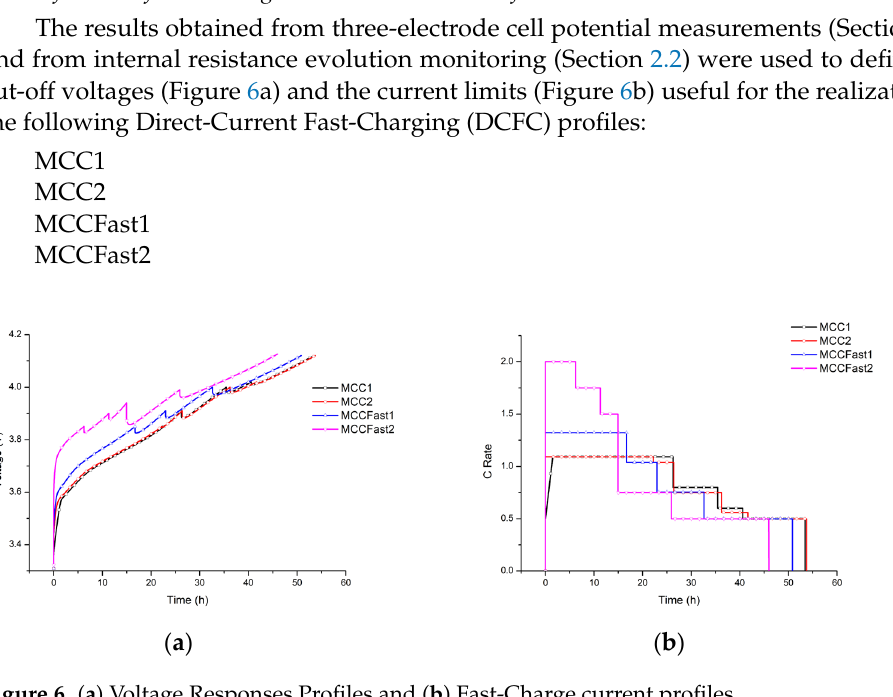
Figure 6. ( a ) Voltage Responses Profiles and ( b ) Fast-Charge current profiles.